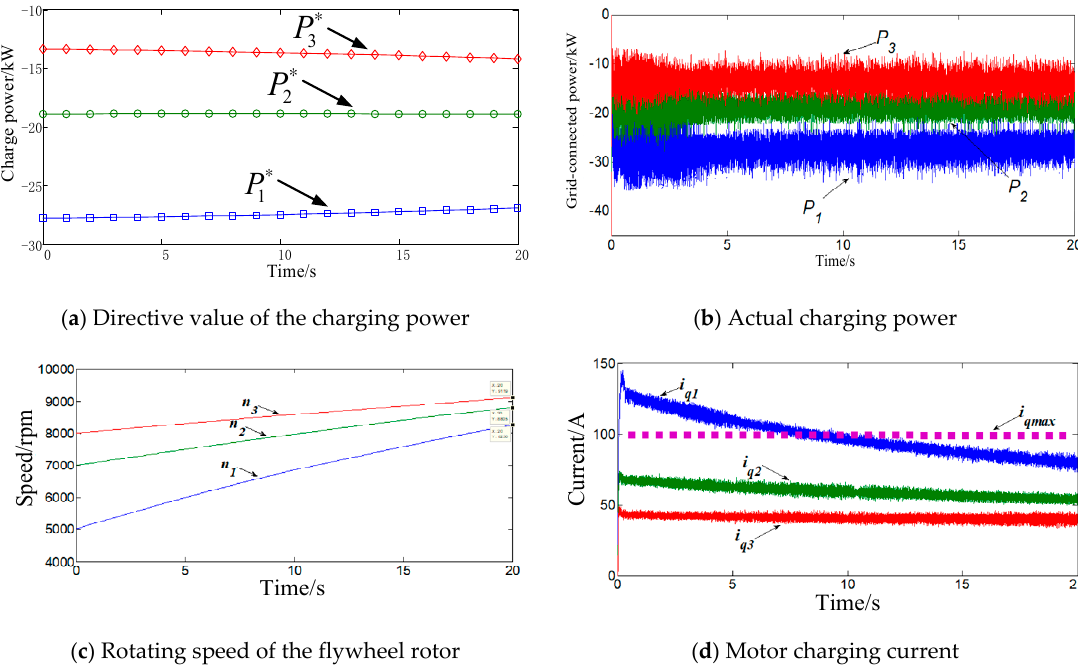
Figure 16. Simulation waveforms of power charging distributed by chargeable energy.